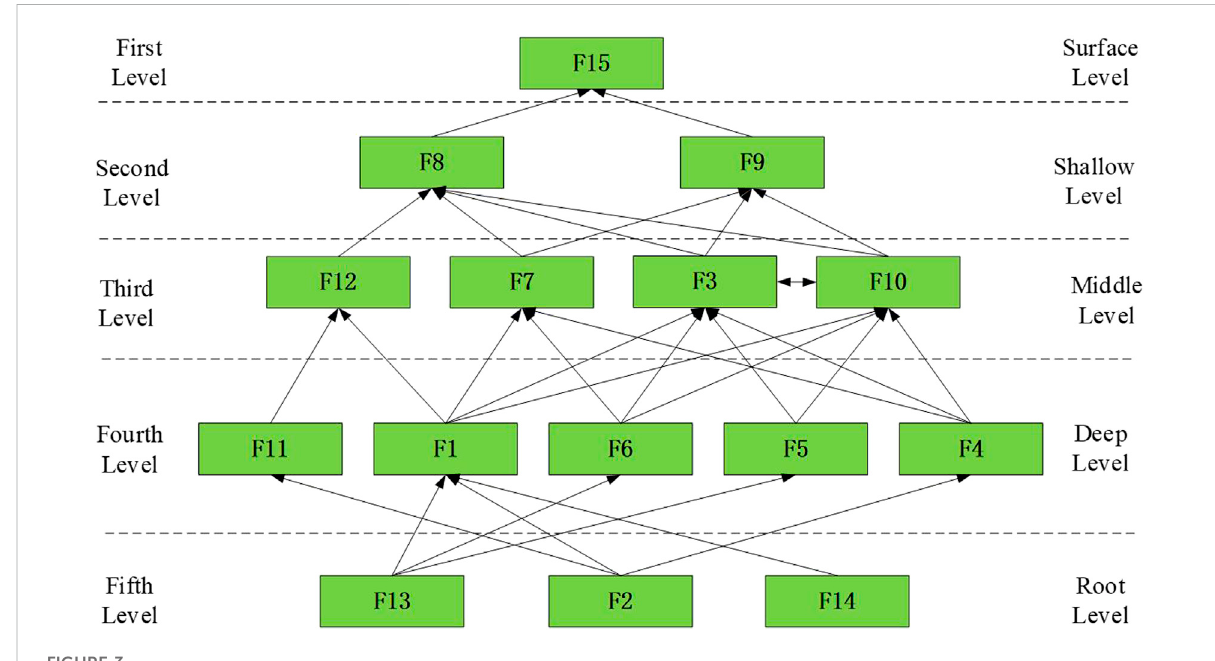
FIGURE 3 Recursive structural model of in fl uencing